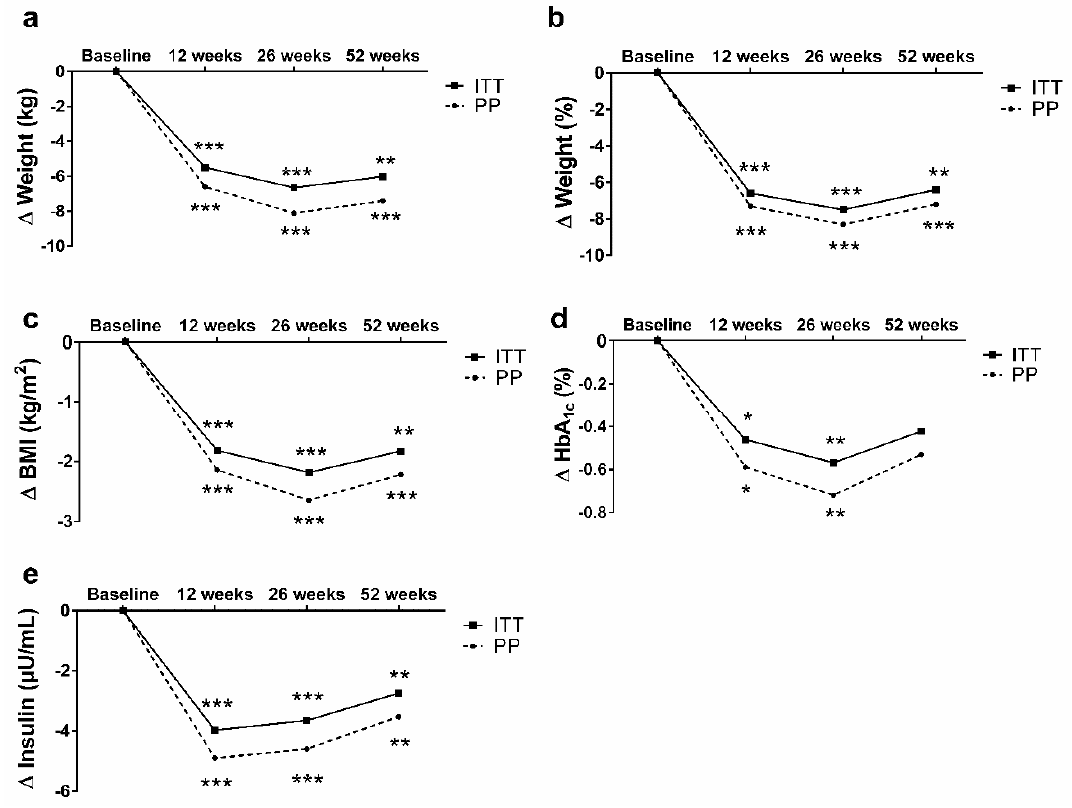
Figure 2. Mean changes in weight ( a , b ), BMI ( c ), HbA1c ( d ) and fasting insulin ( e ) after 12, 26, and 52 weeks of n = 30 (ITT) or n = 25 (PP). Within-group changes were analysed using mixed models adjusting for repeated measurements, baseline values and multiple testing. *** p < 0.001 vs. baseline; ** p < 0.01 vs. baseline; * p < 0.05 vs. baseline; BMI, body mass index; ITT, intention-to-treat analysis; HbA1c, haemoglobin A1c; PP, per-protocol analysis.